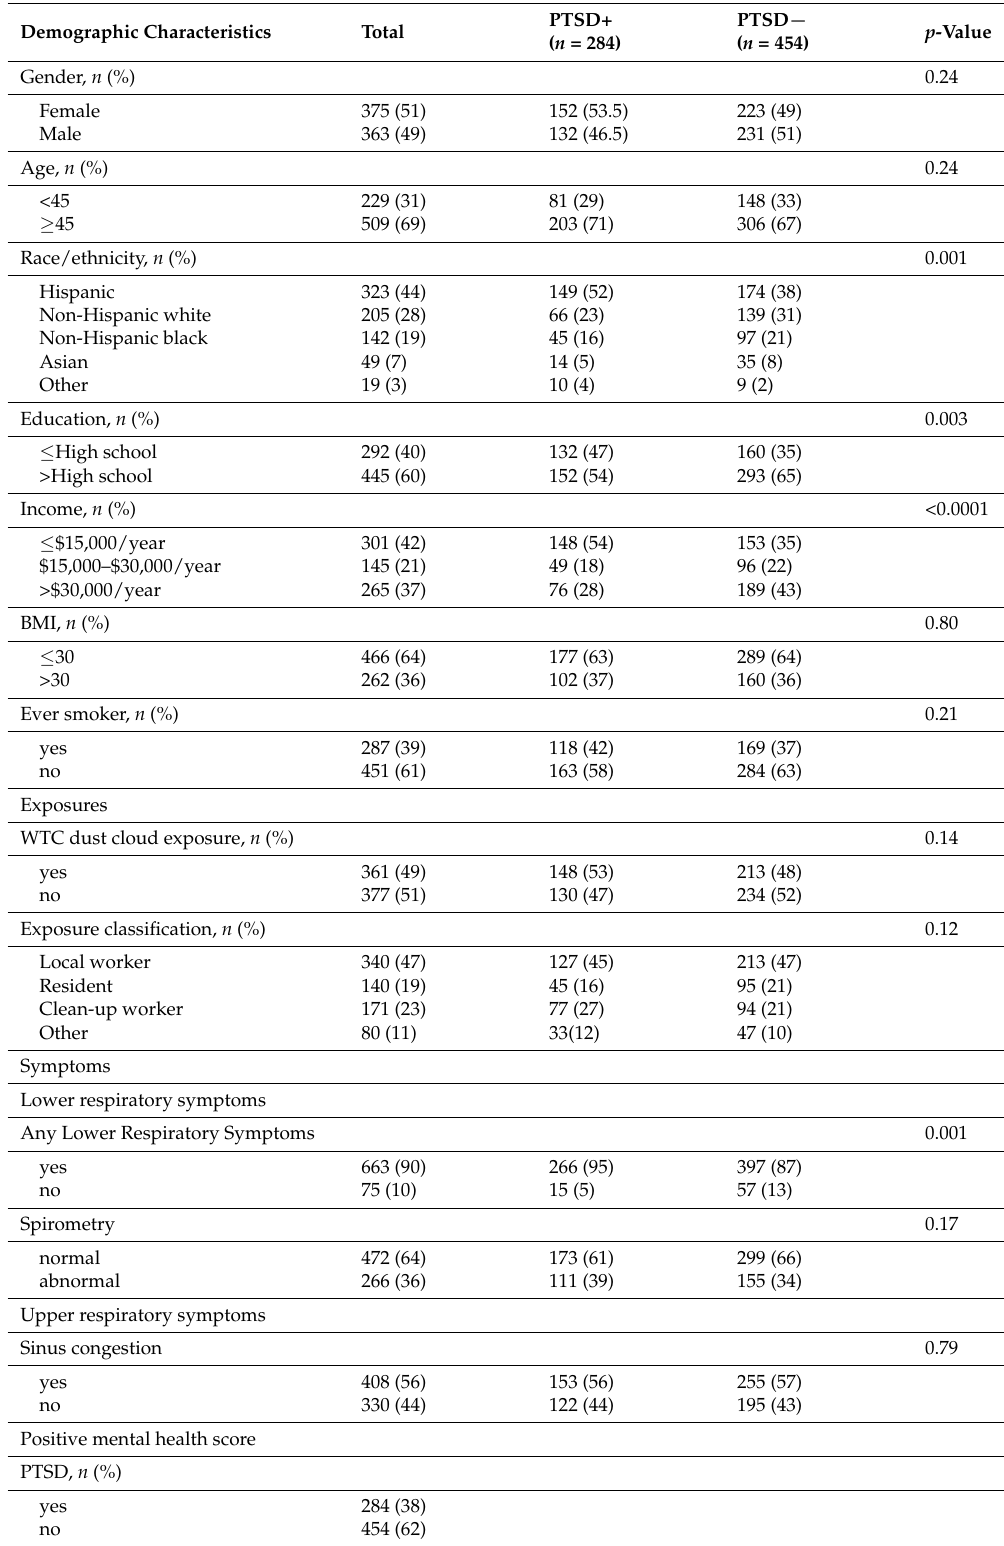
Table 1. Patient characteristics at Initial visit and comparison of PTSD+ and PTSD − patients ( n = 738). Demographic